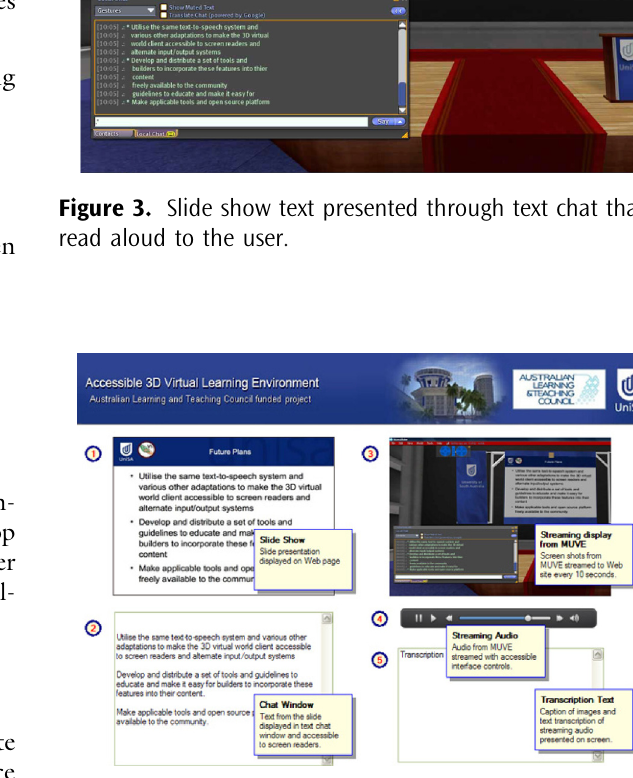
Figure 4. Web-based interface to the